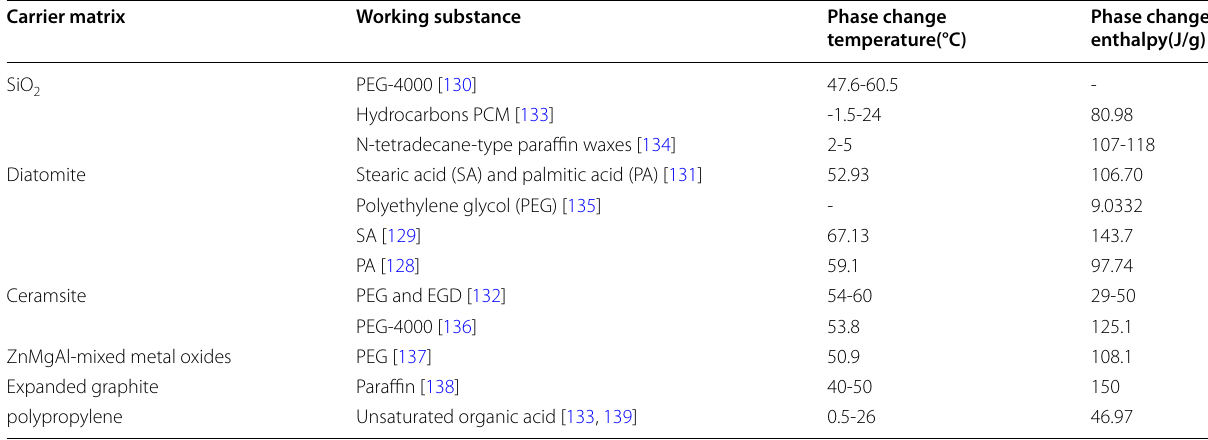
Table 6 Basic properties of different PCMs Carrier matrix Working